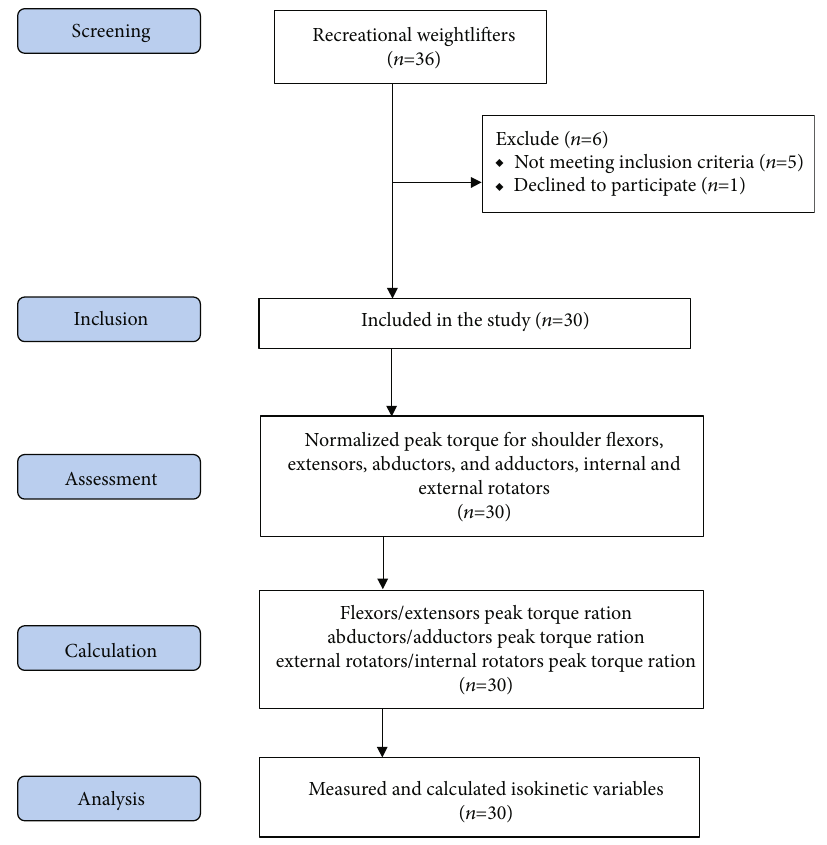
Figure 1: Flowchart of the study